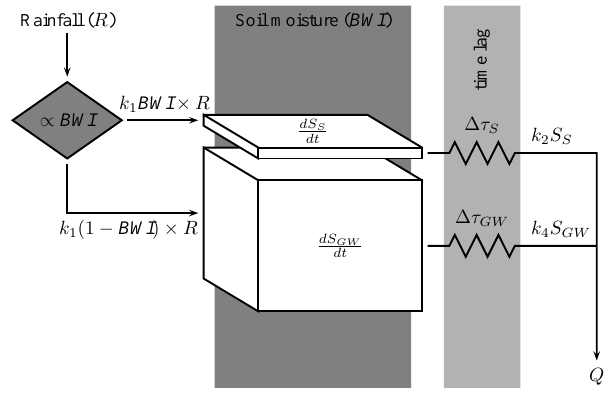
Fig. 4. Structure of the conceptual hydrological model.